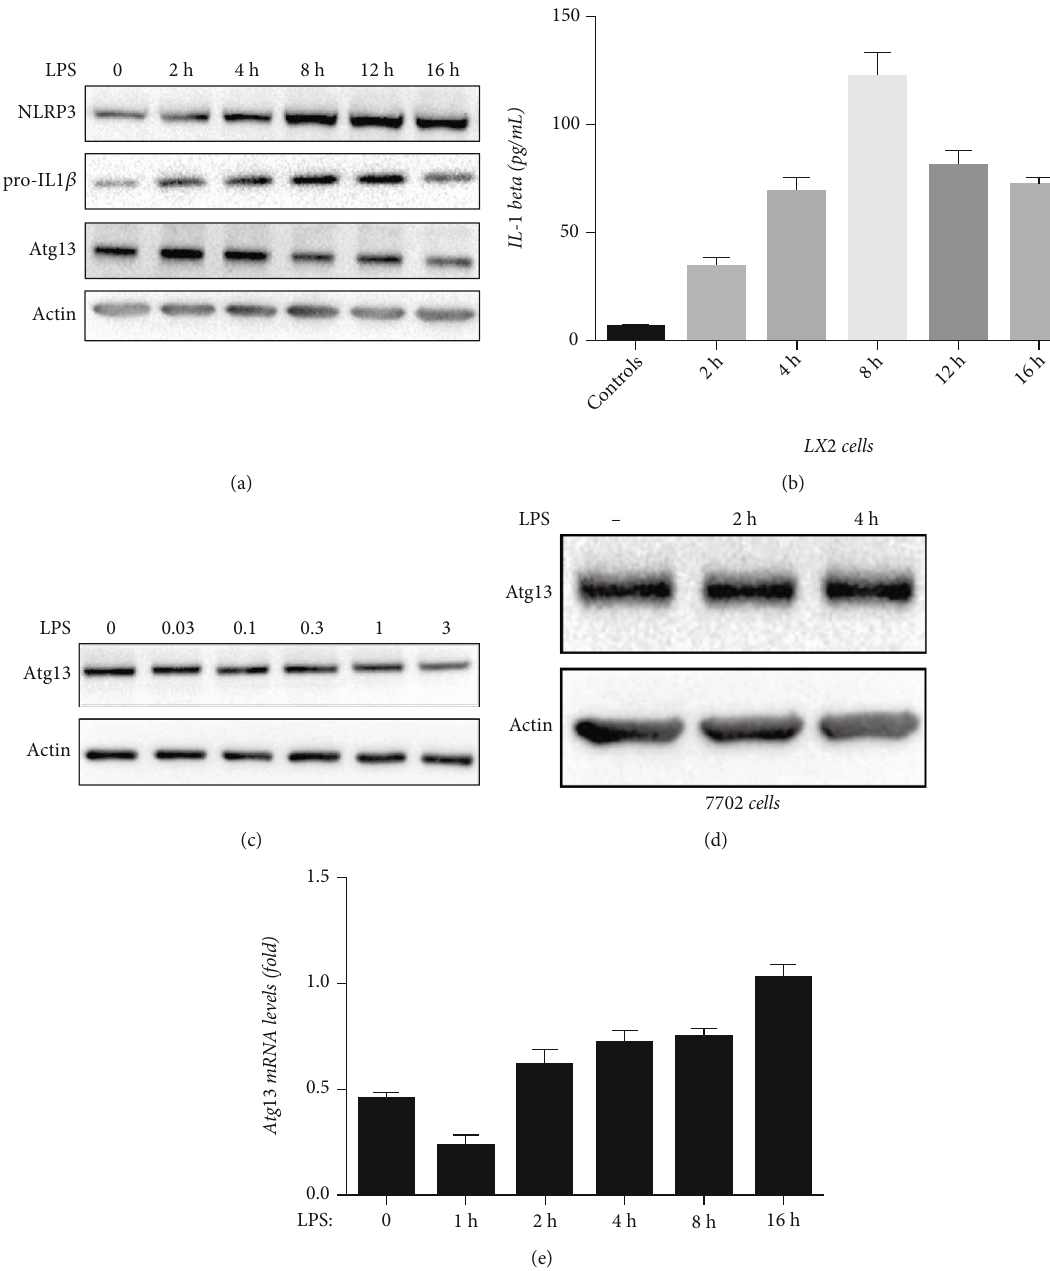
Figure 5: LPS promotes depletion of Atg13 and in fl ammatory responses in LX2 cells. LPS (1 μ g/mL, 0-16h) suppressed expression of Atg13 in a time-dependent manner. (c) LPS (0-3 μ g/mL, 4 h) suppressed expression of Atg13 in a dose-dependent manner. (a, b) LPS (1 μ g/mL, 0-16 h) activated NLRP3 in fl ammasome activation and IL-1 β secretion in a time-dependent manner. (d) LPS (1 μ g/mL, 0-4 h) did not alter the expression of Atg13 in HL-7702 cells. (e) LPS (1 μ g/mL, 0-16) did not alter the mRNA levels of Atg13 in LX2